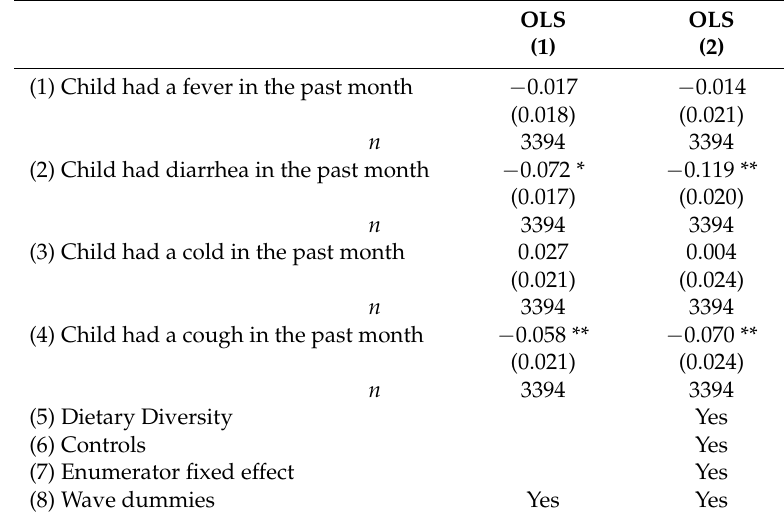
Table 5. Multivariate analysis: Correlations between breastfeeding and health outcomes in children aged 6–18 months in rural China.